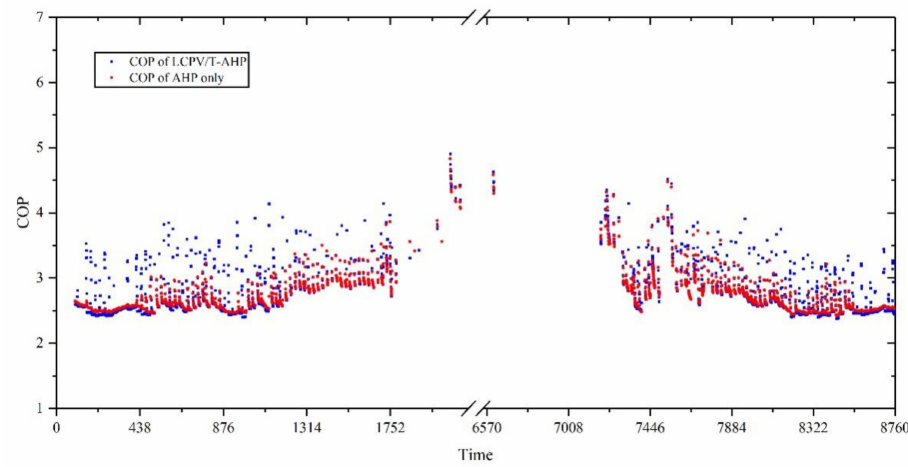
Figure 18. COP comparison between the LCPV/T-AHP system and the AHP only system.